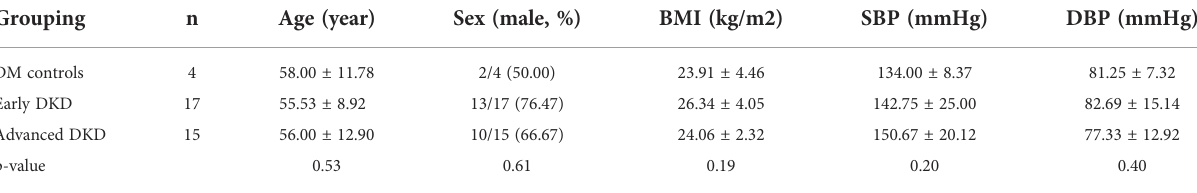
TABLE 1 Biological characteristics of the patients in different